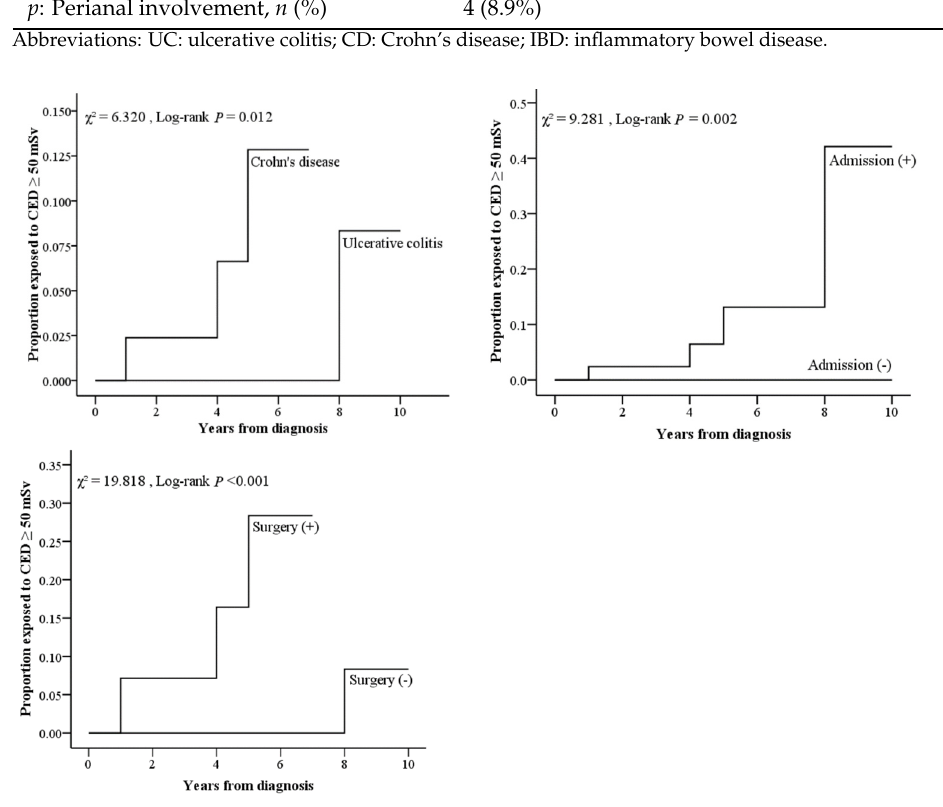
Figure 2. Kaplan–Meier analysis showing a significant difference in the cumulative probability of exposure to CED ≥ 50 mSv after diagnosis between different IBD types, surgery, or hospital admission status.